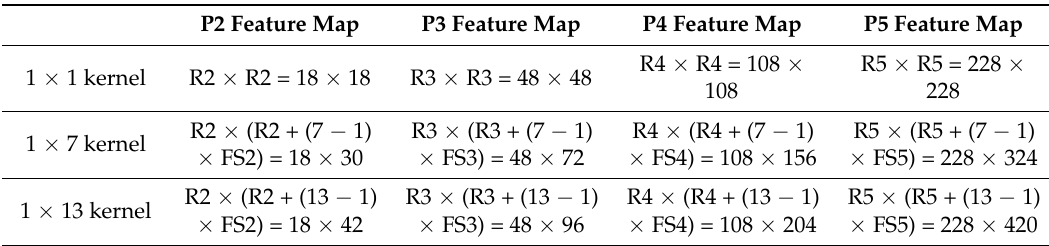
Table 1. Twelve receptive fields with different shapes. The anchor shape is the same with corresponding receptive field. R and FS are the receptive field size and stride of each feature